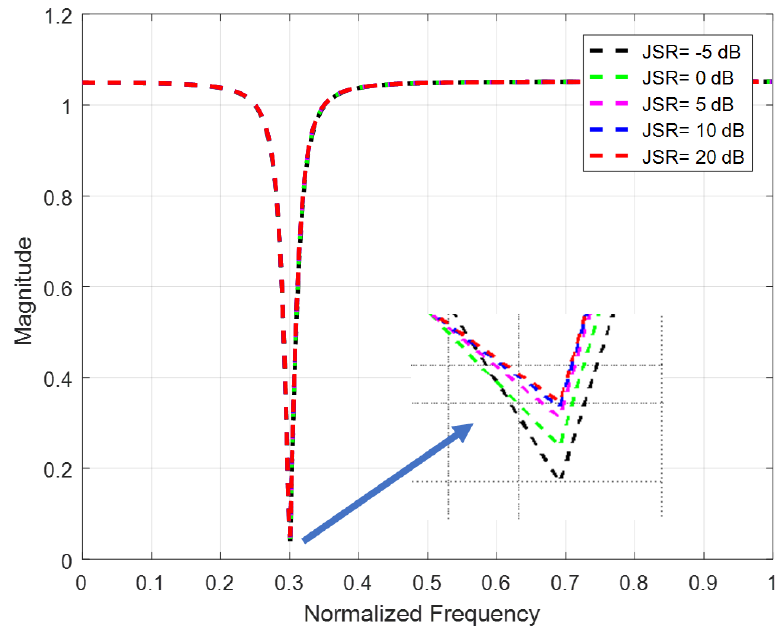
Figure 9. Notch depth vs. JSR.